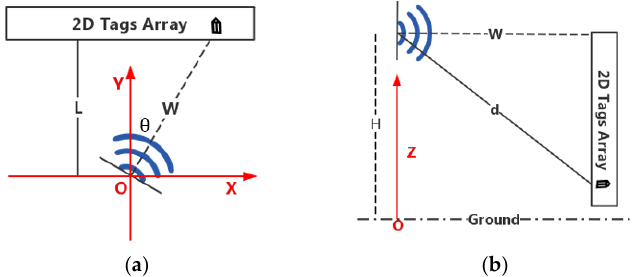
Figure 13. 2D localization principle analysis. ( a ) Top view; ( b ) Sectional view.